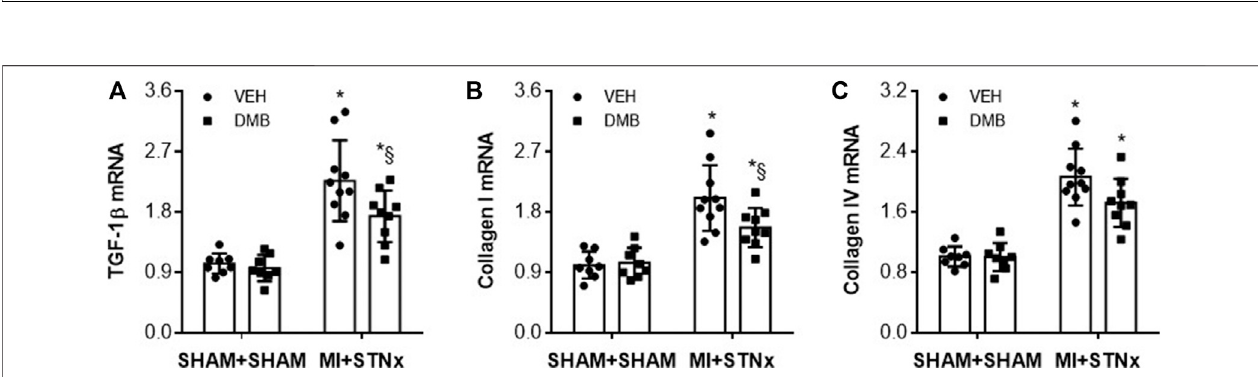
FIGURE 7 | Effects of CRS2 and DMB treatment on gene expression of pro- fi brotic markers TGF- β 1 (A) , Collagen-I (B) and collagen-IV (C) in the kidney. Data are expressed as mean ± SE ( n (cid:1) 8 – 10 for each group). * p < 0.05 vs SHAM + SHAM + VEH; § p < 0.05, MI + STNx + DMB vs MI + STNx + VEH.